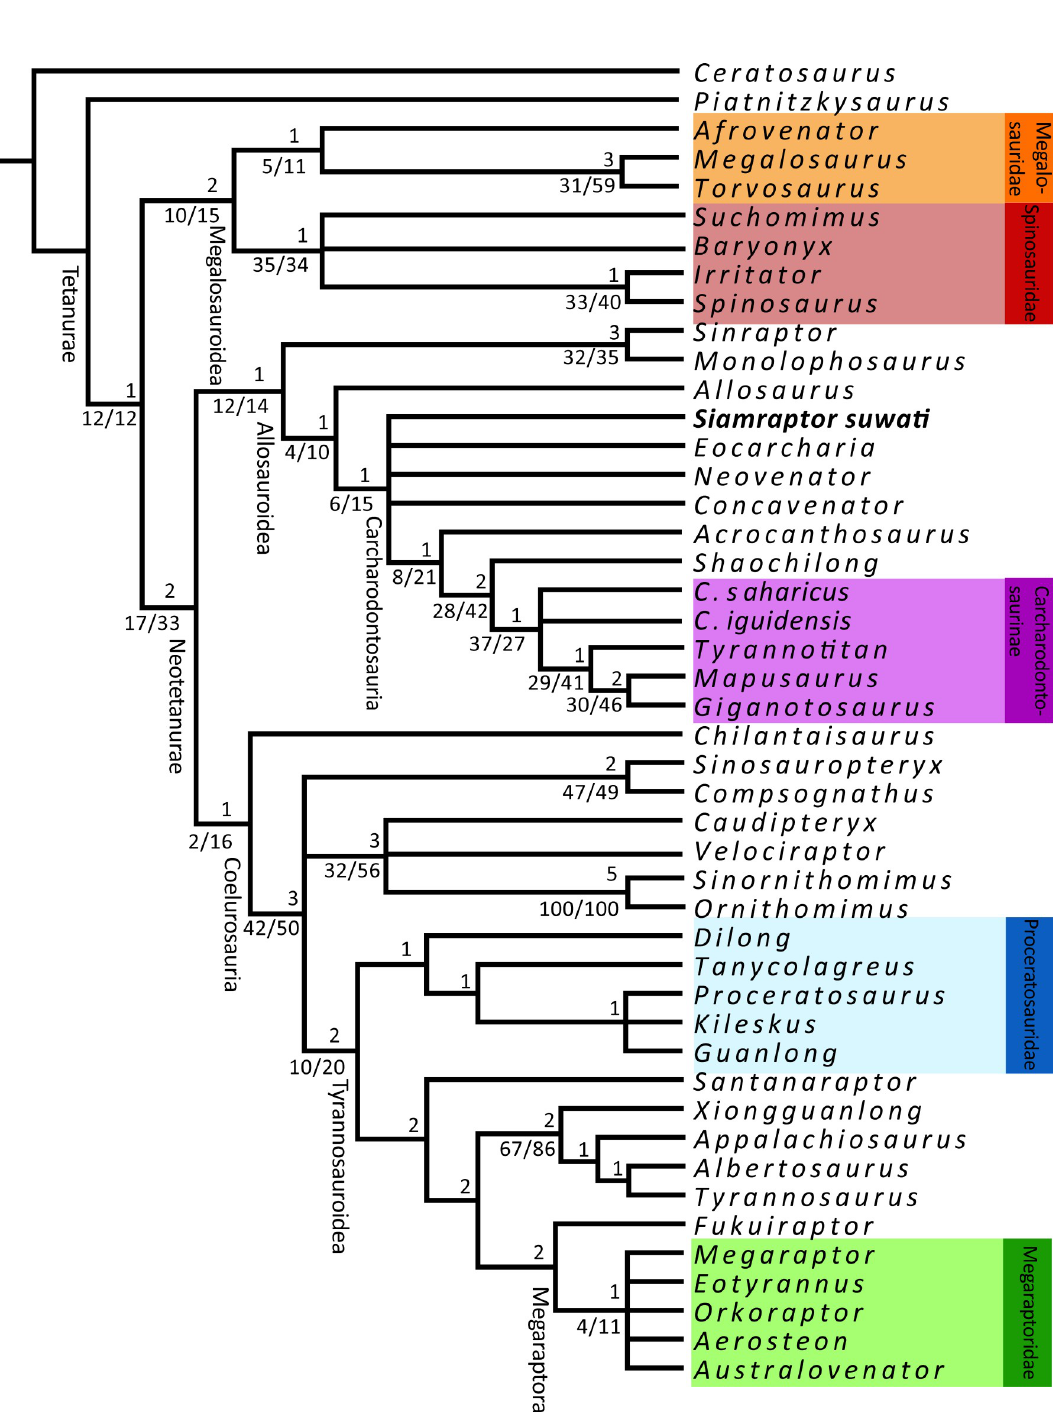
Fig 12. Strict consensus of the phylogenetic analysis based on Carrano et al. [12] matrix. The numbers at the top of the nodes indicate Bremmer support, those at the bottom are bootstraps and jackknife branch support, respectively.